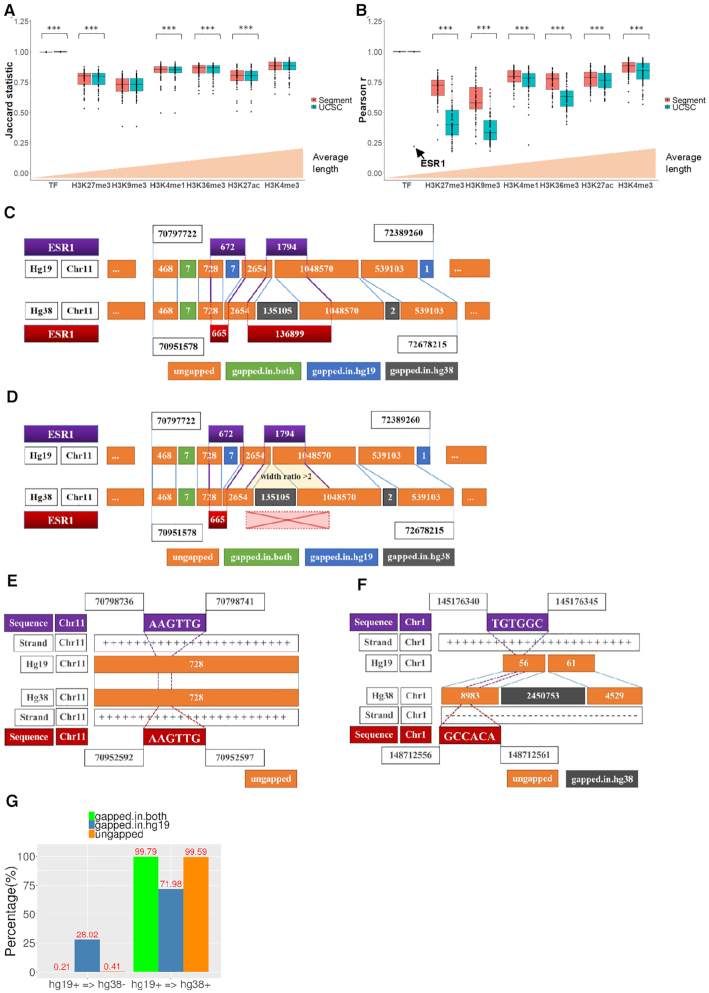
Concordance between liftover and alignment outputs of ChIP-Seq samples using segment_liftover and UCSC liftOver (***P< 0.001). (A) Box plot showing Jaccard statistic of similarity between the two outputs using segment_liftover and UCSC liftOver. (B) Box plot showing Pearson correlation coefficients of intervals length between the two outputs using segment_liftover and UCSC liftOver. (C) Corrupted positions of sample ESR1 were converted by UCSC liftOver. (D) Corrupted positions of sample ESR1 were filtered by segment_liftover. (E) Liftover of sequence, a general example. (F) Liftover of sequence, a corrupted example. (G) Percentage of base pair of contigs unchanged/changed of strand from hg19 to hg38.